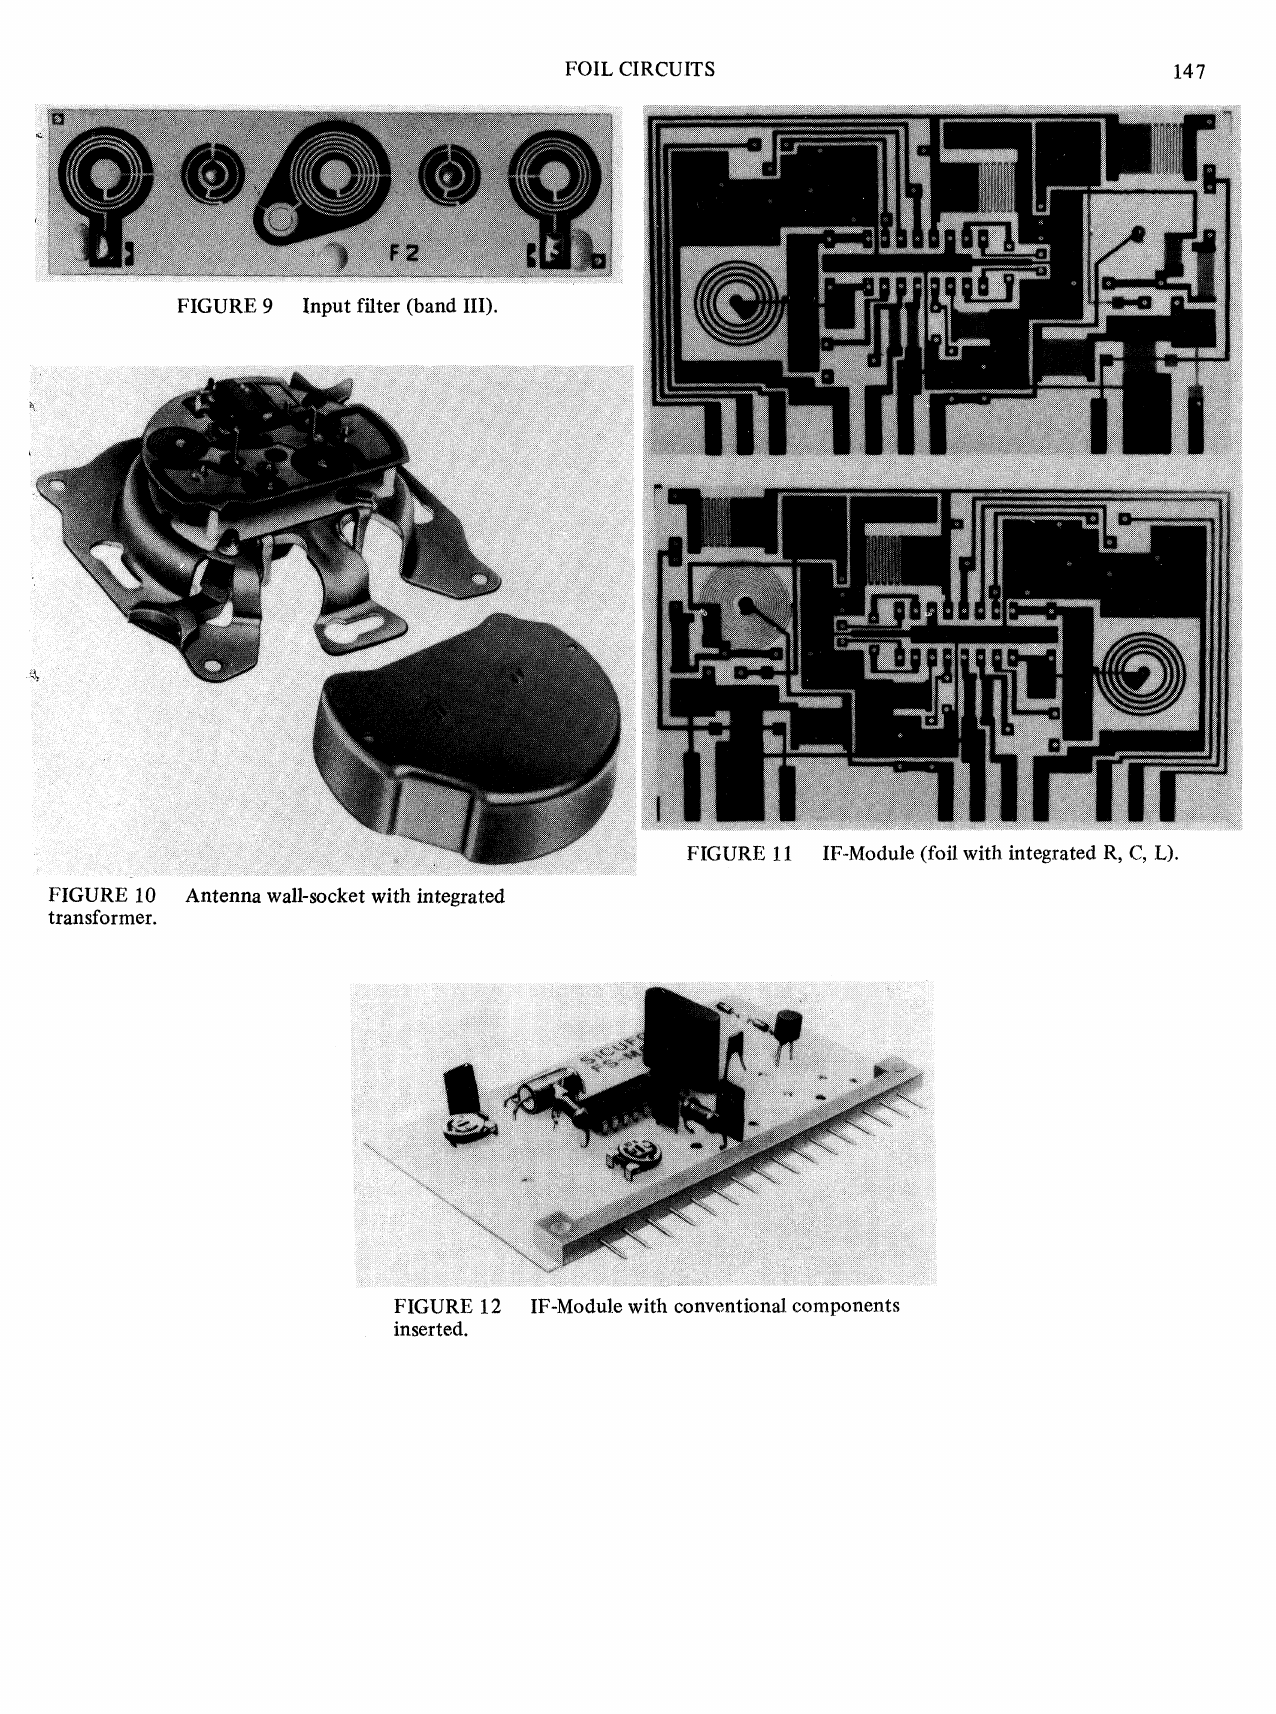
FIGURE 12 IF-Module with conventional inserted.